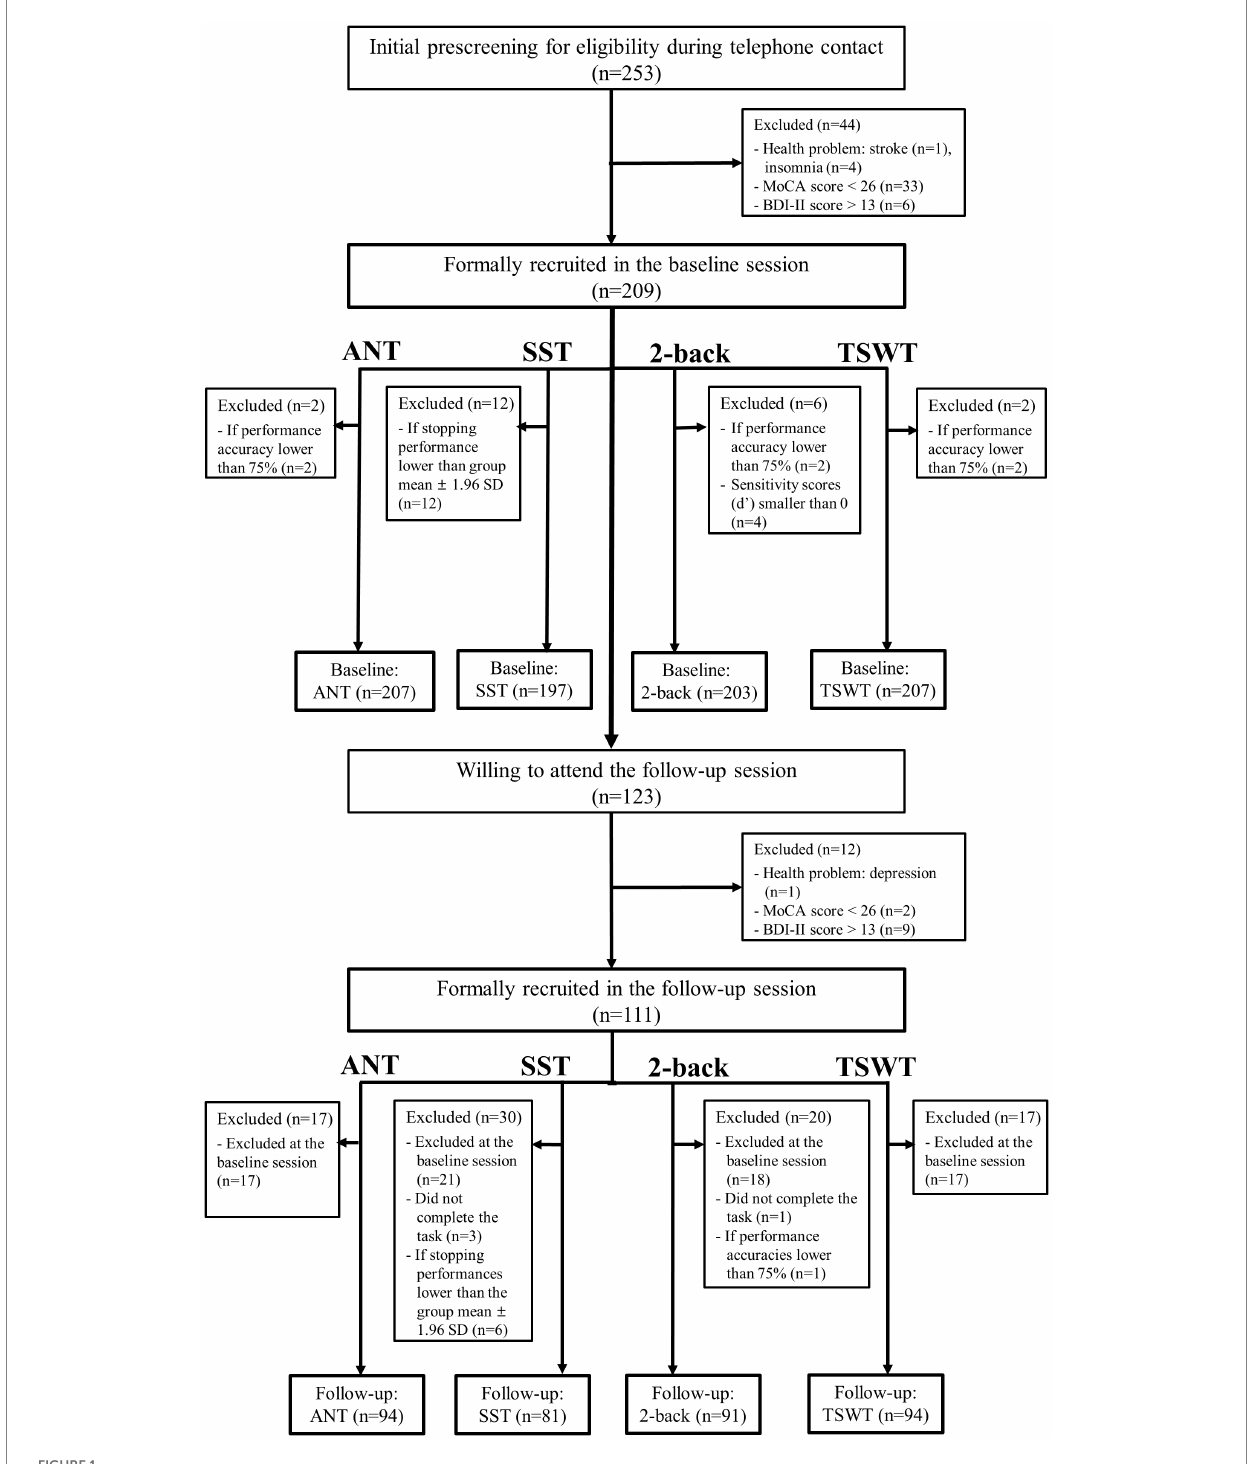
FIGURE 1 A flowchart indicates the screening criteria and numbers of participants for each of the four cognitive tasks (ANT, Attentional Network Test; SST, Stop- signal task; 2-back task; TSWT, Task-switching task) in the baseline and follow-up sessions. “n” denotes the number of participants either included or excluded. MoCA, Montreal Cognitive Assessment; BDI-II, Beck Depression Inventory–II; SD, standard